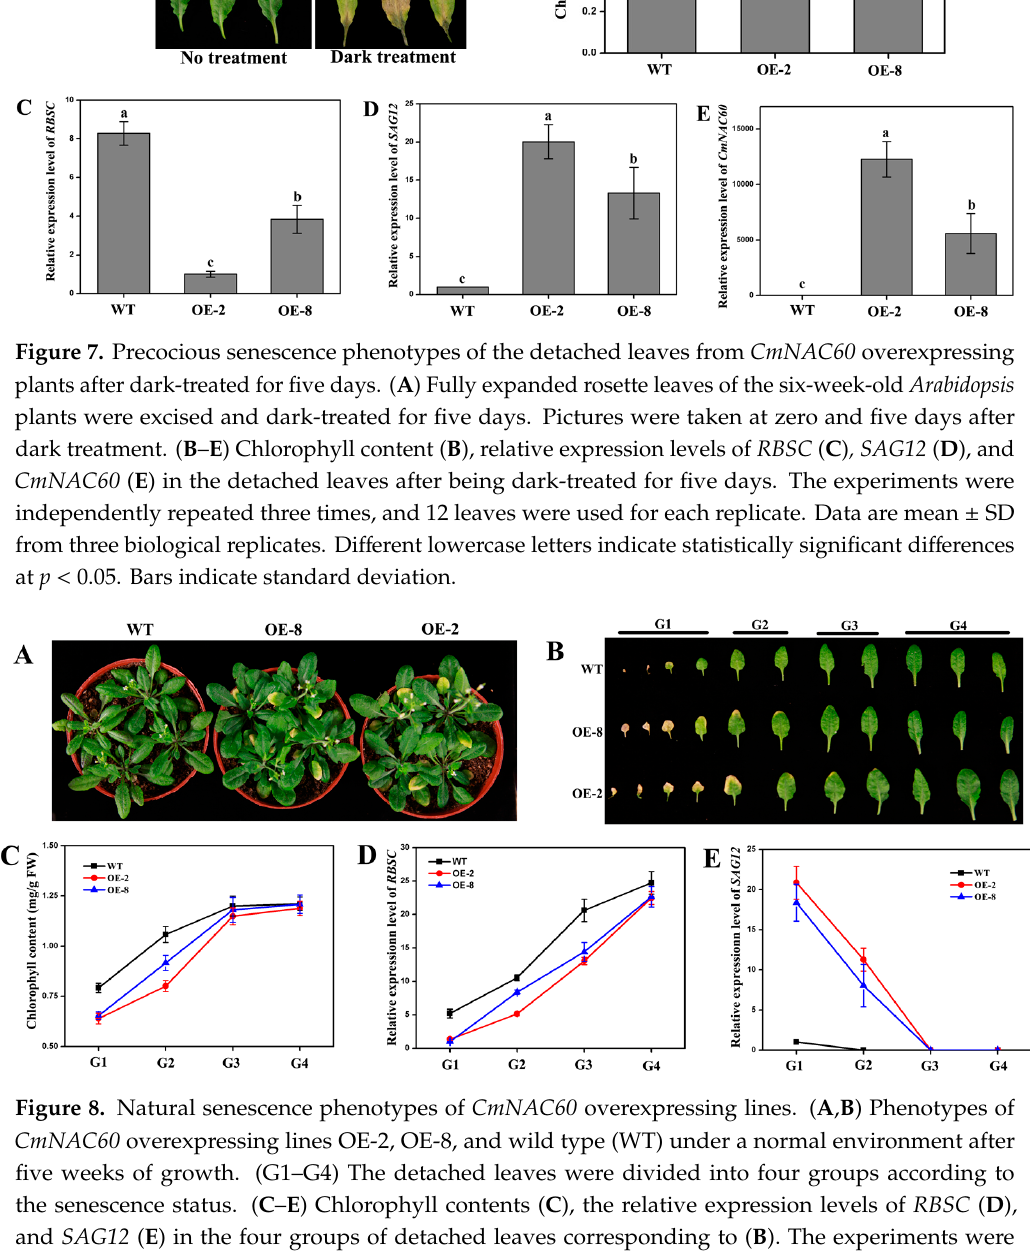
Figure 8. Natural senescence phenotypes of CmNAC60 overexpressing lines. ( A , B ) Phenotypes of CmNAC60 overexpressing lines OE-2, OE-8, and wild type (WT) under a normal environment after five weeks of growth. ( G1 – G4 ) The detached leaves were divided into four groups according to the senescence status. ( C – E ) Chlorophyll contents ( C ), the relative expression levels of RBSC ( D ), and SAG12 ( E ) in the four groups of detached leaves corresponding to ( B ). The experiments were independently repeated three times, and 12 plants were used each time. Data are mean ± SD from three biological replicates. Bars indicate standard deviation.